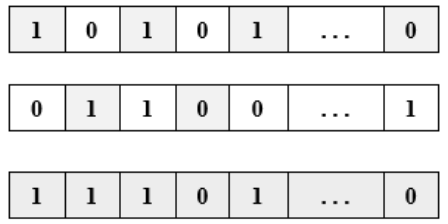
Fig. 8. Uniform crossover operator for binary structure Sjt.